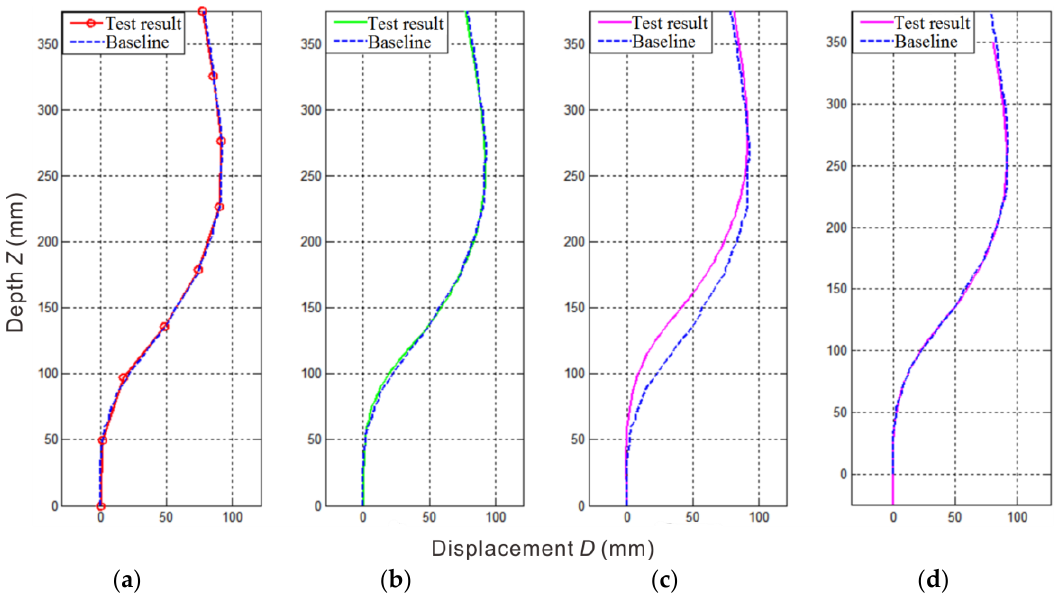
Figure 6. Displacement curves obtained with different calculation methods: ( a ) original displacement polyline; ( b ) displacement curve calculated by Equation (11); ( c ) displacement curve calculated by Equation (12); ( d ) displacement curve calculated by Equation (13).